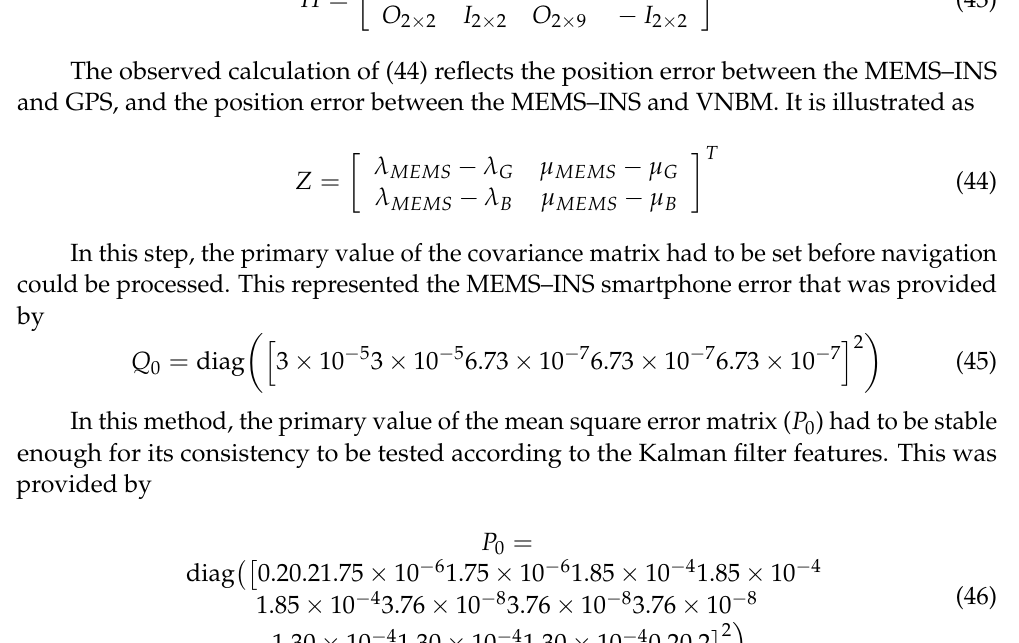
Figure 8. Reference trajectory and reference landmarks.